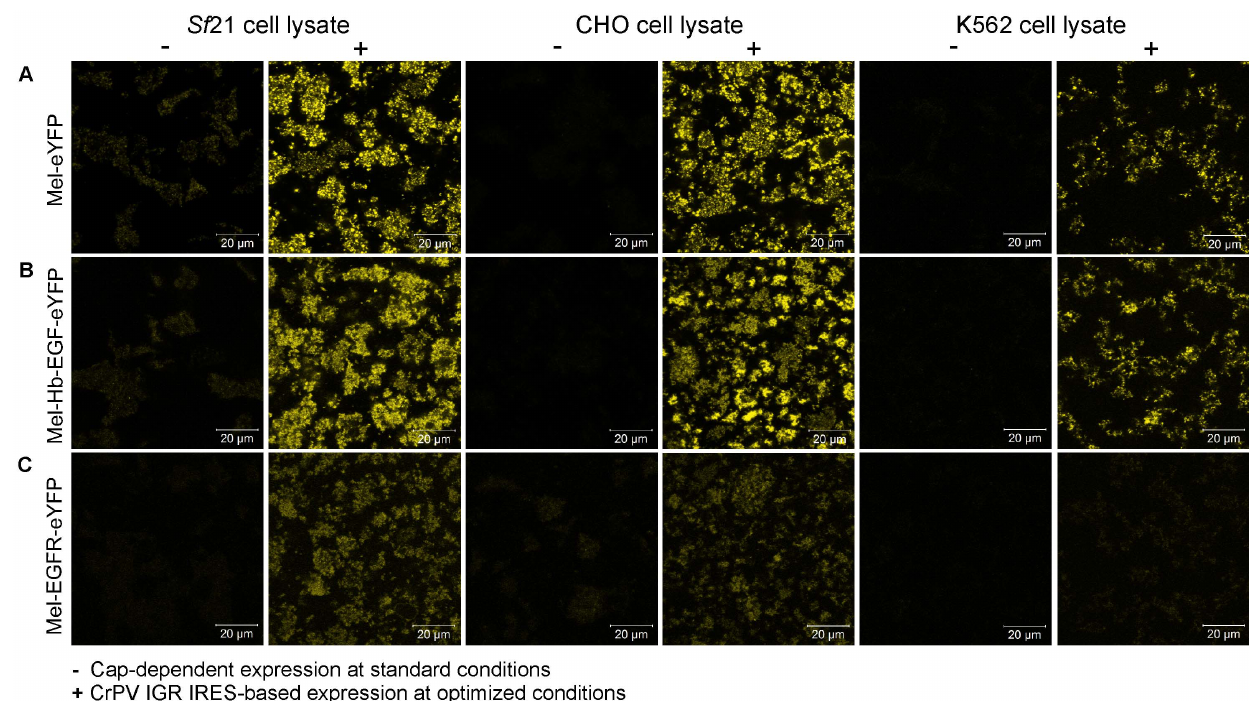
Figure 5. CLSM analysis of eYFP-tagged proteins synthesized in coupled Sf 21, CHO and K562 cell-free expression systems. CLSM images depict the de novo synthesized secreted protein Mel-eYFP (A) as well as the membrane proteins Mel-Hb-EGF-eYFP (B) and Mel-EGFR-eYFP (C). Plasmids encoding the target proteins were equipped with ( + ) or without ( 2 ) the CrPV IGR IRES (GCU). In the case of Mel-eYFP, fluorescent vesicles indicate the translocation of the target protein into the lumen of the endogenous microsomes present in cell-free systems based on cultured Sf 21, CHO and K562 cells. In the case of Mel-Hb-EGF-eYFP and Mel-EGFR-eYFP, microsomes show a fluorescent membrane due to the insertion of de novo synthesized membrane proteins. eYFP was excited at 488 nm and fluorescence emission was recorded with a long-pass filter in the wavelength range above 505 nm (LSM 510 Meta microscope, Zeiss).